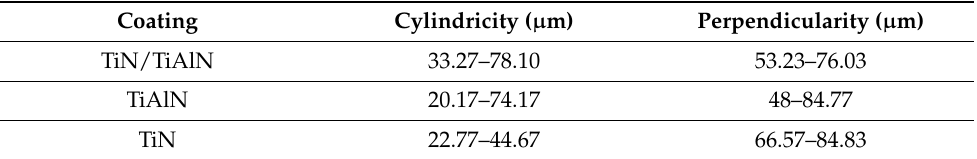
Table 8. Range of hole cylindricity and perpendicularity for each tool